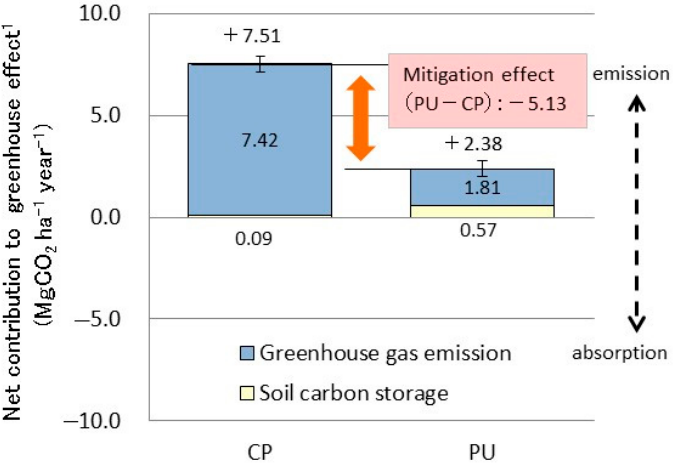
Figure 3. GHG emission and absorption in the experimental field. 1 CO 2 conversion. Error bar is shown as standard deviation in the GHG emission.